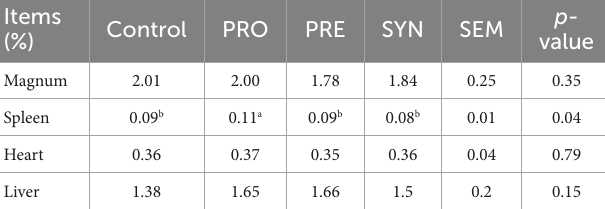
TABLE 7 Effects of dietary treatments on the organ index of laying hens.